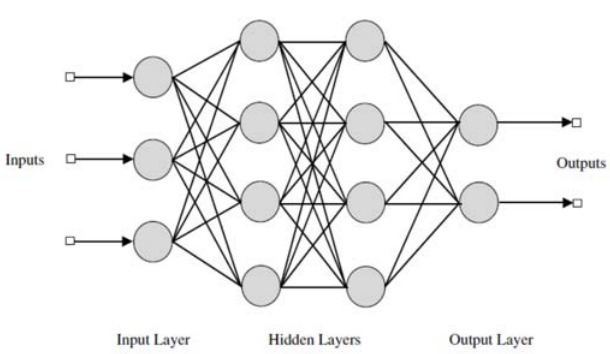
Figure 1. Neural network structure.